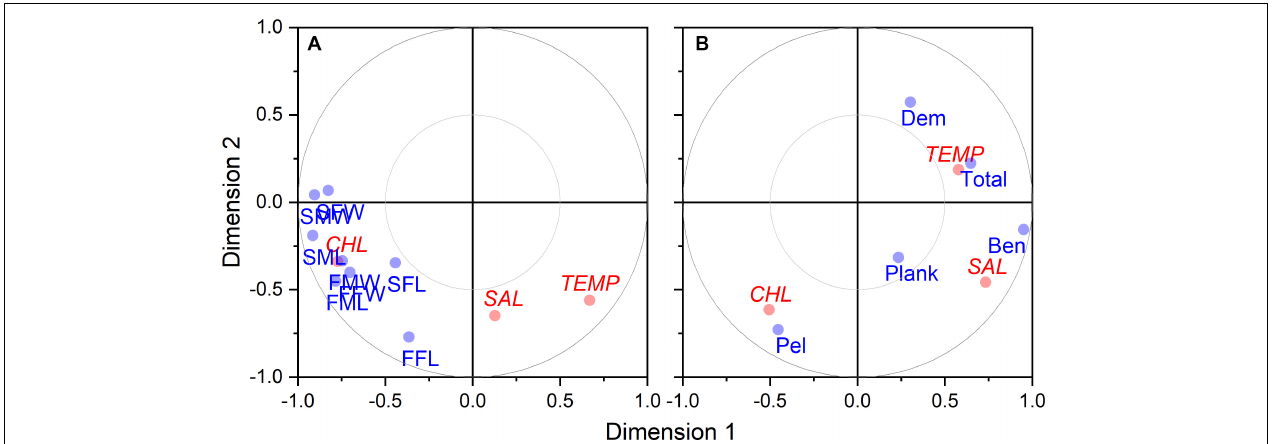
FIGURE 9 | Canonical correlation two-dimensional plot of environmental factors vs. growth (A) and biomass (B) variables. Environmental variable (shown in red) include temperature (TEMP), salinity (SAL), and CHL. Growth variables (shown in blue) are coded with first position as S for spring and F for fall, second position as M for males and F for females, and third positons as W for weight and L for length. Biomass variables (shown in blue) include benthivores (BEN), demersal piscivores (DEM), pelagic piscivores (PEL), planktivores (PLANK), and total biomass (TOTAL).